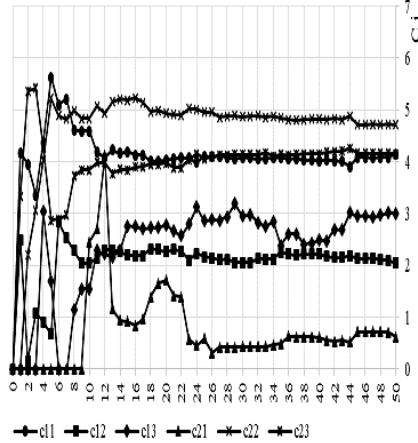
Figure 2. Step-by-step estimates of the transport table .